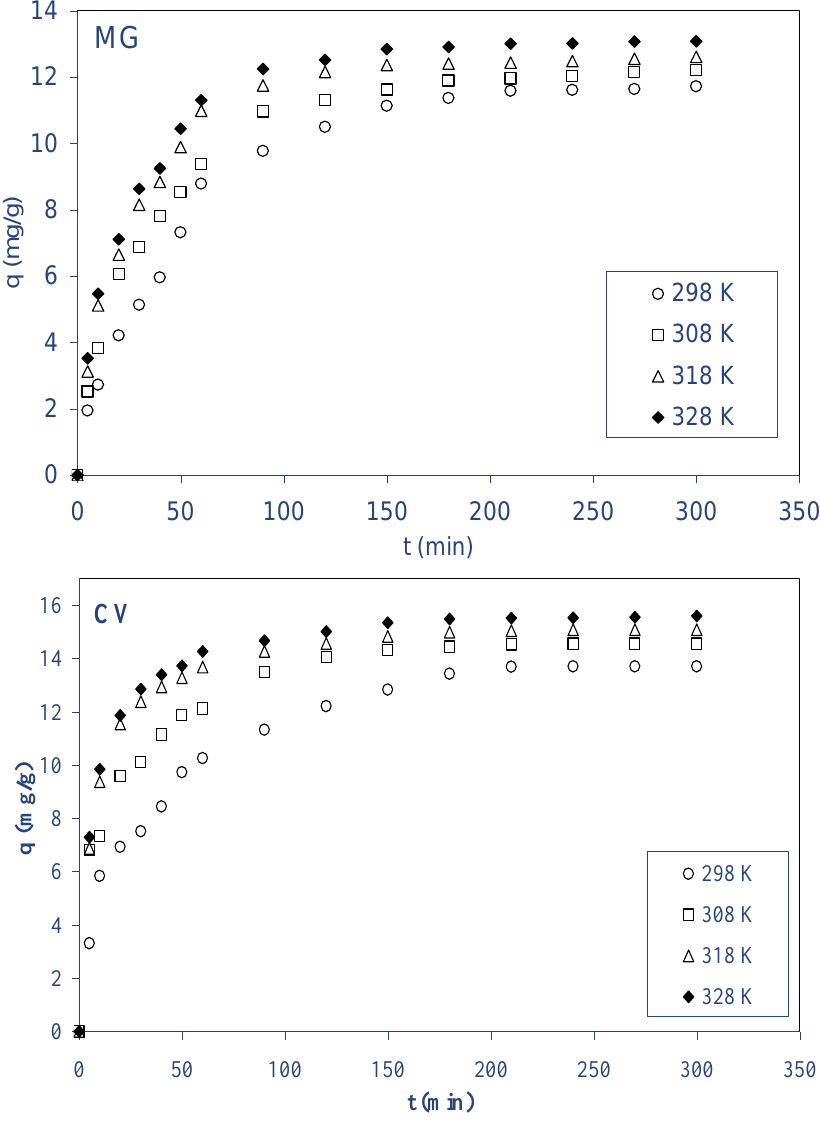
Figure 6. Effect of temperature on the biosorption of MG and CV on ALP (conditions: C 0 : 40 mg/L; biosorbent dosage: 2.5 g/L; stirring speed: 400 rpm; pH (MG): 4, pH (CV): 6.5, T: 298–328 Table 4. Thermodynamic parameters for the biosorption of MG and CV on ALP.